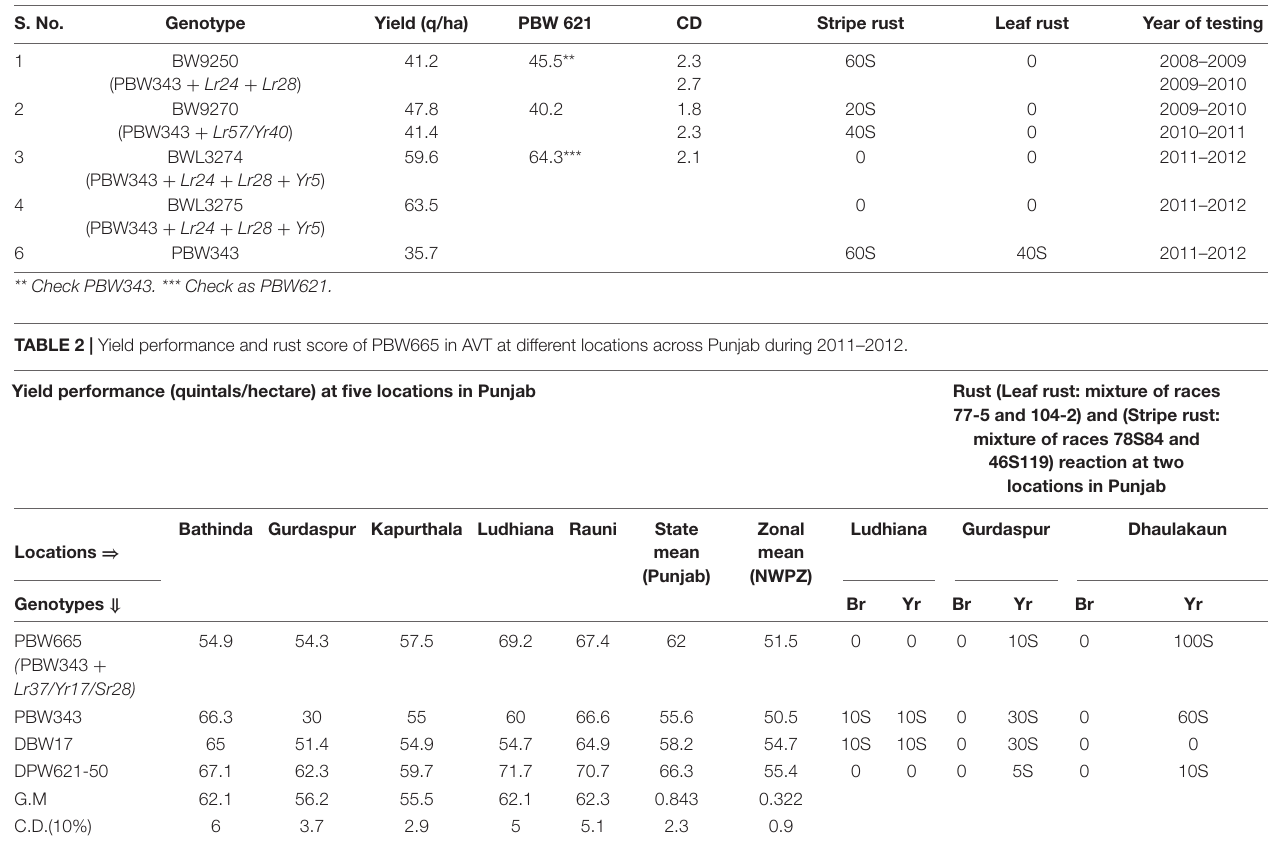
TABLE 1 | Yield performance and rust score for selected lines with different gene introgressions at PAU, Ludhiana. S. No.